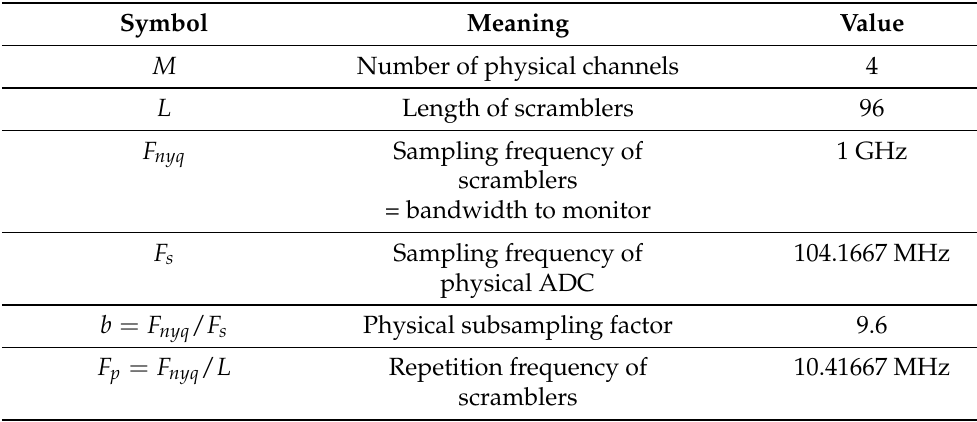
Table 1. Parameters of our MWC